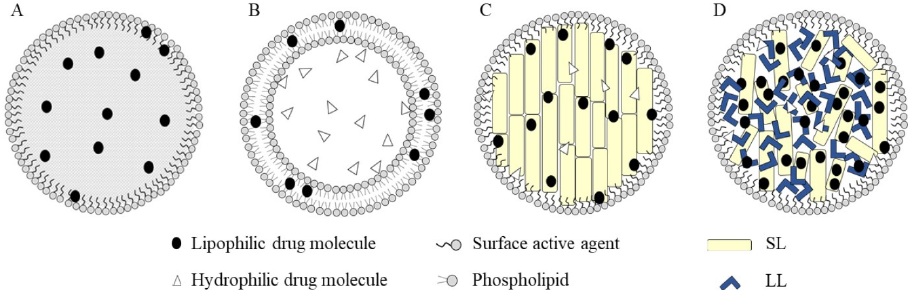
Figure 6. Different types of lipid-based nanoparticles: nanoemulsions ( A ); liposomes ( B ); solid lipid nanoparticles ( C ) and nanostructured lipid carriers ( D ). (SL = solid lipids, LL = liquid lipids) Adapted from [75], Copyright 2020 MDPI.